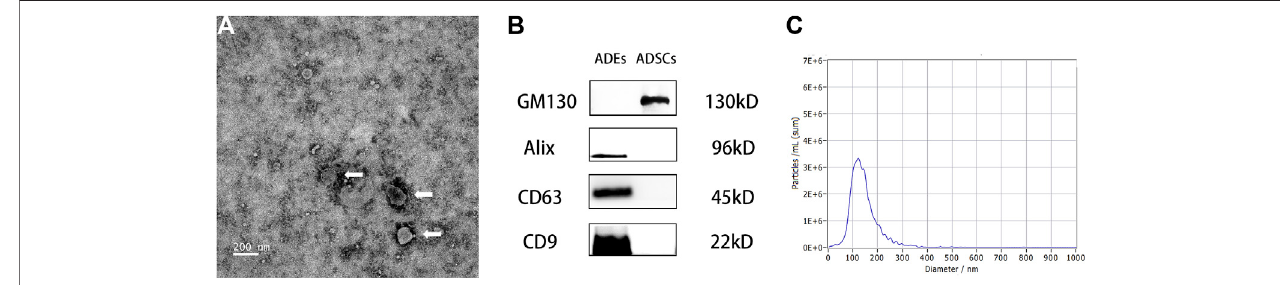
Frontiers in Bioengineering and Biotechnology |